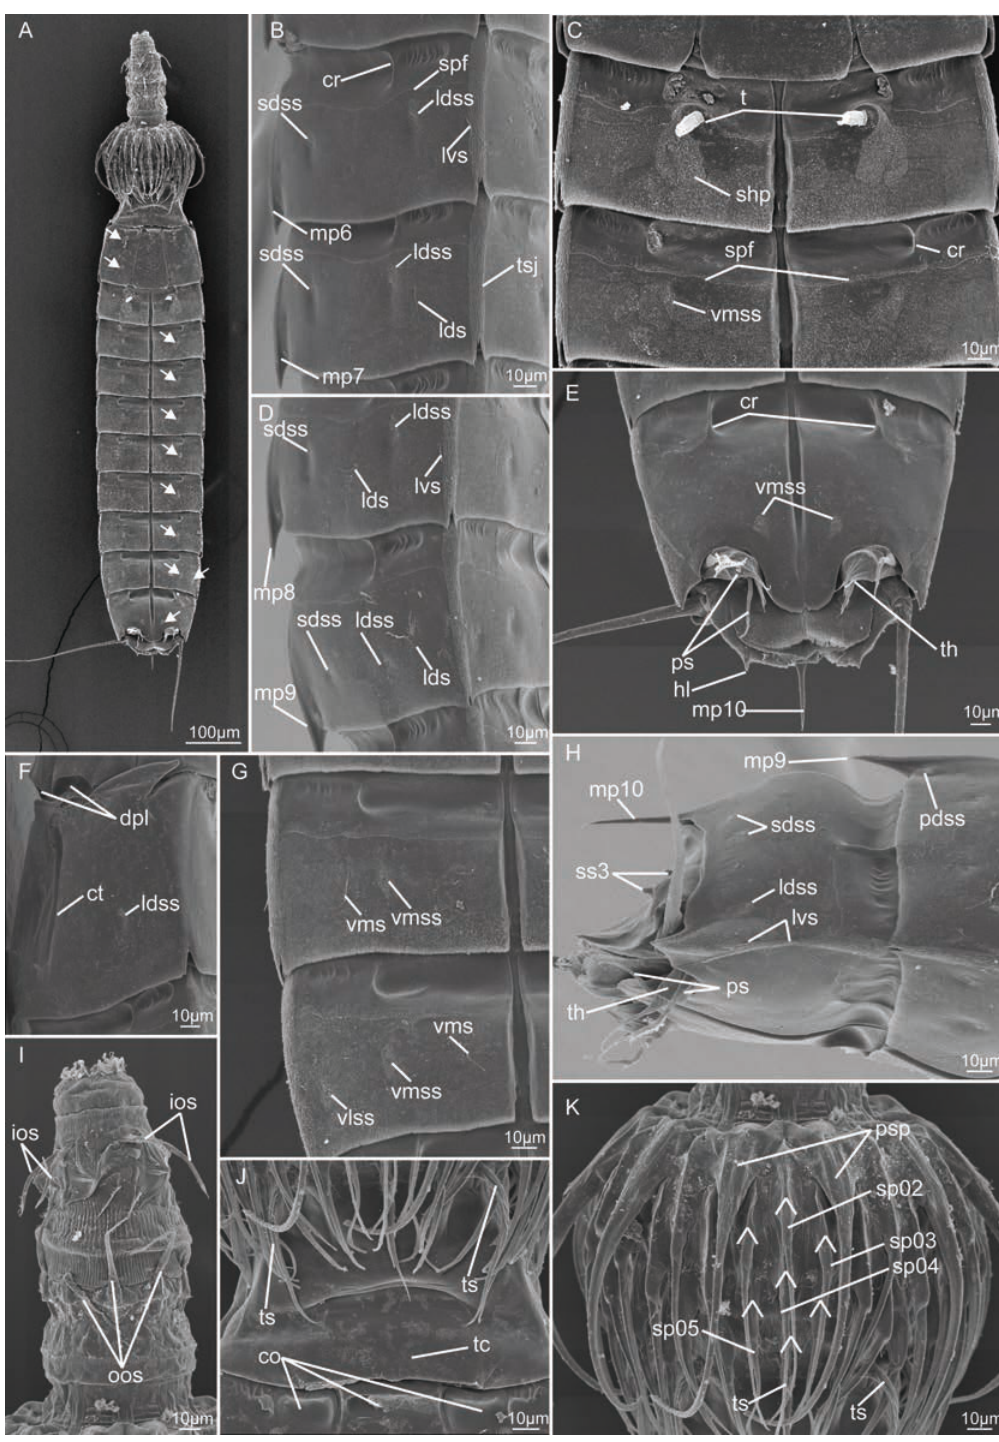
F ig . 10. – Pycnophyes cristatus n. sp. SEM photographs of male. A, ventral view; B, lateral view of segments 6-7; C, ventral view of segments 2-3; D, lateral view of segments 8-9; E, ventral view of segments 10-11; F, lateral view of segment 1; G, ventral view of segments 8-9; H, lateral view of segments 9-11; I, mouth cone; J, ventral view of segment 1 and the thin cuticle of the introvert; K, male, introvert sector 1; co cuticular ornamentation, cr cuticular ridge, ct cuticular thickening, dpl dorsal placid, hl horn-like extension, ios inner oral style, lds laterodor- sal seta, ldss laterodorsal sensory spot, lvs lateroventral seta, mp middorsal process, oos outer oral style, pdss paradorsal sensory spot, ps penile spine, psp primary spinoscalid, sdss subdorsal sensory spot, shp short hairs patch, sp spinoscalid, spf secondary pectinate fringe, ss3 sensory spot type 3, t tube, tc thin cuticle of the introvert, th tuft of hairs, ts trichoscalid, tsj tergosternal junction, vlss ventrolateral sensory spot, vms ventromedial seta, vmss ventromedial sensory spot. Sensory spots are marked with white arrows on A. Digits following labels refer to segment numbers except on K where they refer to the introvert ring numbers. Lambda symbols ( Λ ) mark attachment points of